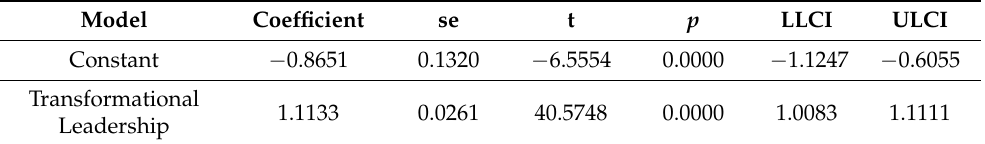
Table 10. Coefficients of Regression (path-c).